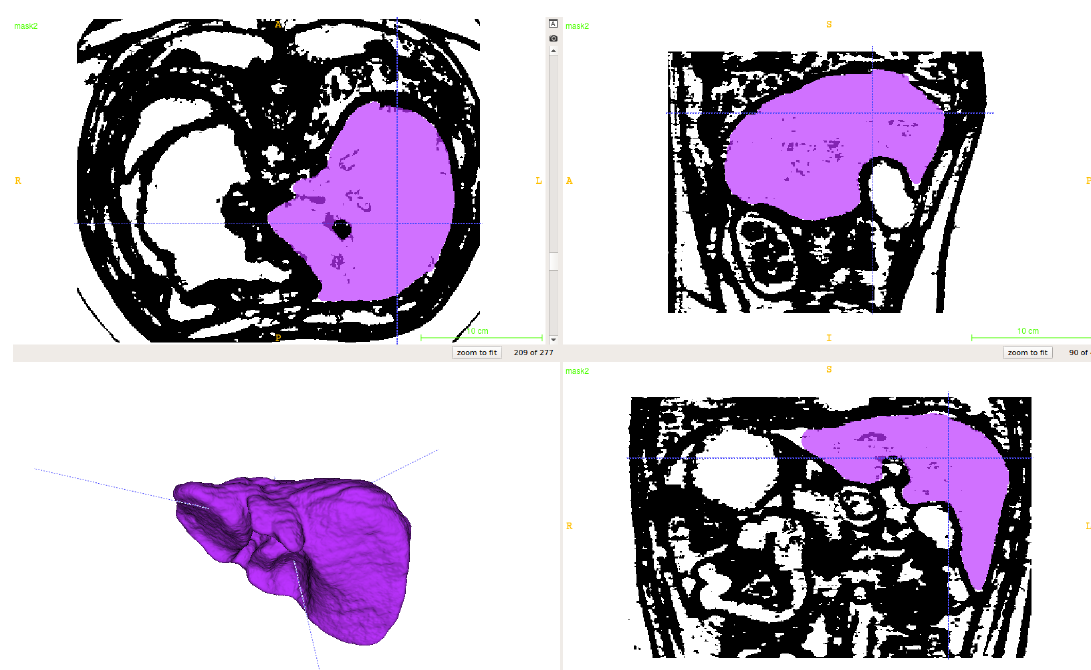
Figure 6. Results of liver segmentation: α = 0.2, β = 0.95.